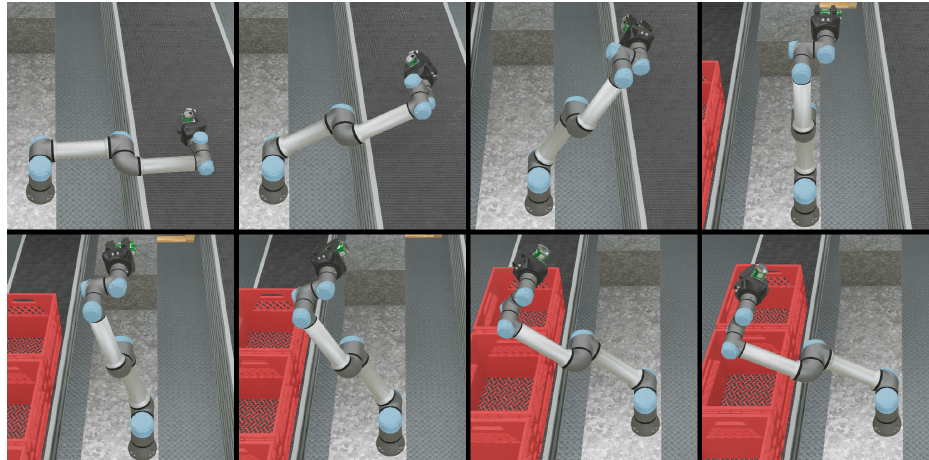
Figure 10. Positions of the simulated movement of the UR5e robot holding the payload in the gripper.